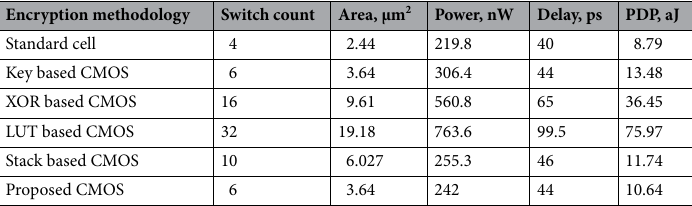
Table 14. Results comparison for NOR gate.